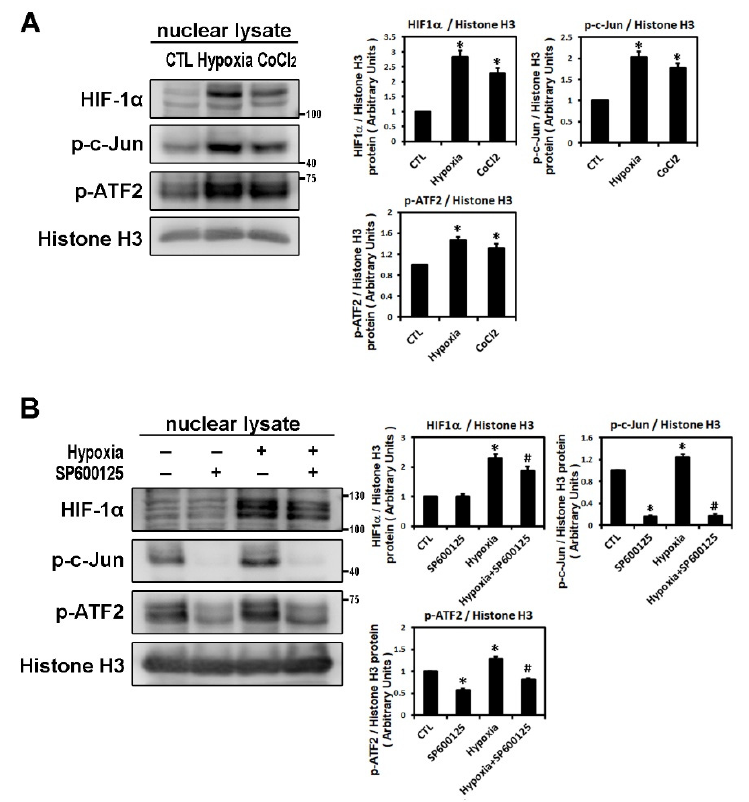
Figure 5. Analysis of nuclear fraction from hypoxia-treated HL-1 cardiomyocytes that modulated by JNK transduction pathway. Panel A : Nuclear lysates were analyzed by Western blots to determine levels of HIF-1 α , p -c-Jun, p-ATF2 in HL-1 cells under the control condition (no treatment), treatment with CoCl2 (10 − 4 M) for 6 h, or hypoxia (1% O 2 ) for 6 h. The data are mean ± SEM ( n = 4 per group, * p < 0.05 vs. control) from four independent experiments. Panel B : Representative Western blots and levels of HIF-1 α , p-c-Jun, p-ATF2 in the nuclear lysate of HL-1 cells pre-treated with SP600125 (10 − 5 M) or DMSO as a vehicle for 30 min, then treated with hypoxia stress (1% O 2 ) for 6 h. The bar graph shows the value of each sample relative to that of control cells under normoxia (vehicle only) or hypoxic condition. The data are mean ± SEM ( n = 3 per group, * p < 0.05 vs. control; # p < 0.05 vs. hypoxia) from three independent experiments.